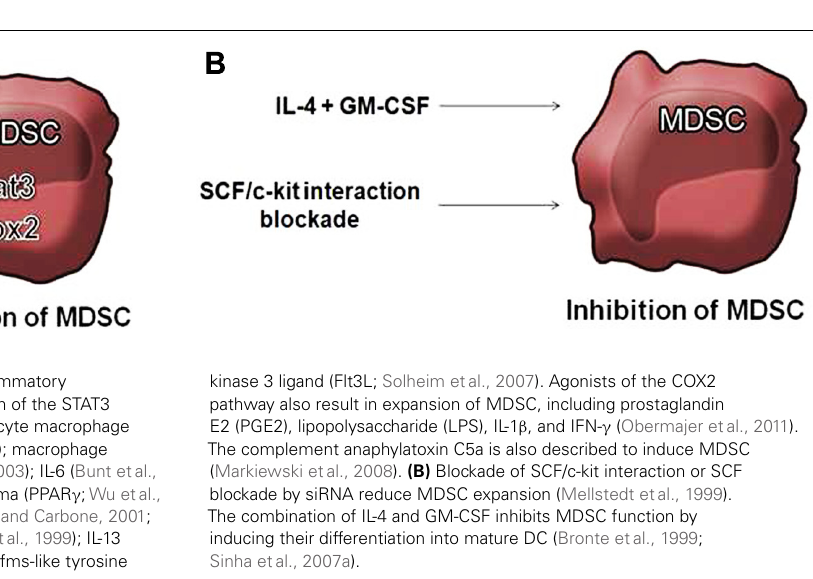
FIGURE 1 | Control of MDSC by cytokines. (A) Inflammatory environments lead to expansion of MDSC by activation of the STAT3 signaling pathway by several factors including granulocyte macrophage colony-stimulating factor (GM-CSF; Bronte etal., 1999); macrophage colony-stimulating factor (M-CSF; Kusmartsev etal., 2003); IL-6 (Bunt etal., 2007); peroxisome proliferator-activated receptor-gamma (PPAR γ ;Wu etal., 2012); vascular endothelial growth factor (VEGF; Ohm and Carbone, 2001; Melani etal., 2003); stem cell factor (SCF; Mellstedt etal., 1999); IL-13 (Gallina etal., 2006); Hps72 (Chalmin etal., 2010); and fms-like tyrosine